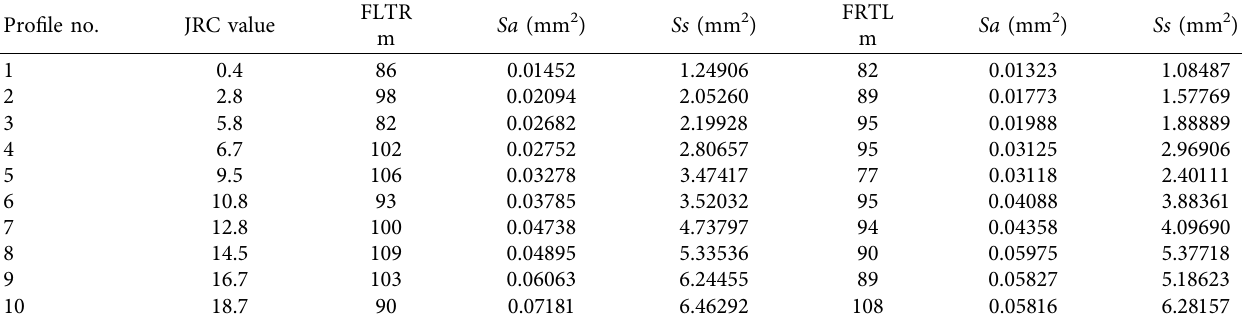
Table 2: Values of Sa and Ss calculated under the shear condition of FLTR and FRTL.